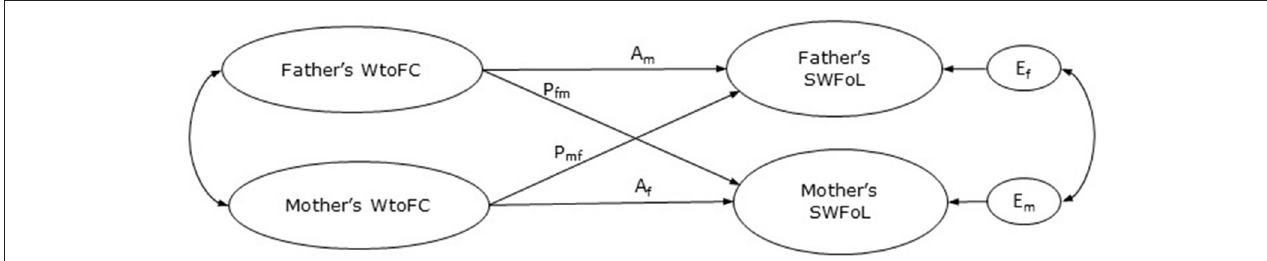
FIGURE 1 | Basic actor-partner interdependence model of work-to-family conflict (WtoFC) and satisfaction with food-related life (SWFoL). A m , actor effect of father’s WtoFC on his own SWFoL; A f , actor effect of mother’s WtoFC on her own SWFoL; P fm , partner effect of father’s WtoFC on mother’s SWFoL; P mf , partner effect of mothers’s WtoFC on fathers’s SWFoL; E f and E m , residual errors on SWFoL for the father and mother,